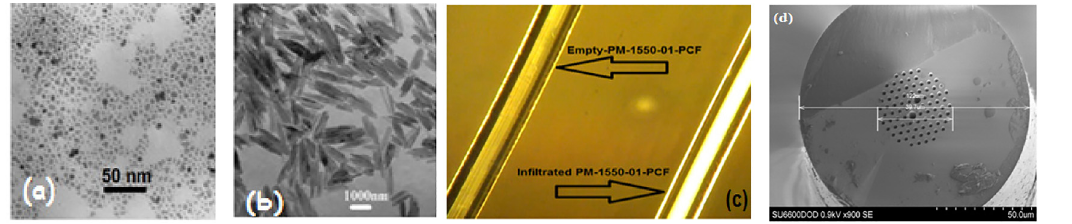
Figure 22: TEM images of (a) spherical magnetic nanoparticles, (b) rod-like magnetic nanoparticles, (c) polarizing microscope images of empty and in fi ltrated PCF in crossed polarizers, and (d) SEM image of the PM-1550- 01-PCF cross-section